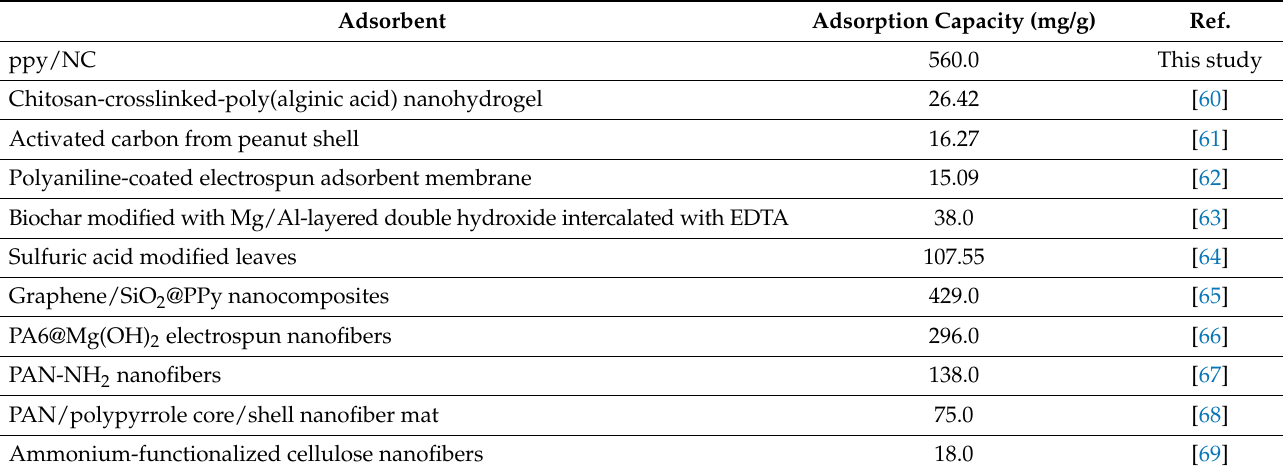
Table 3. The comparison between the removal of Cr(VI) ions on the surface of ppy/NC nanocomposite and reported